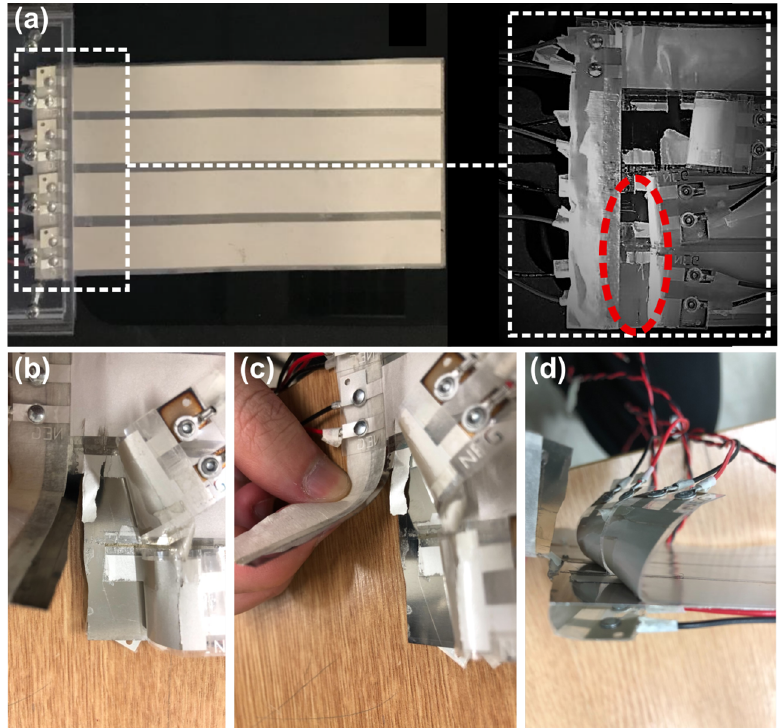
Figure 6. ( a ) Inverted flag before the endurance test and detail of the failed flag after testing: the inset shows the flag where the clamp has been removed and the PVDF strips have been lifted to inspect the metal core and reveal the vertical crack responsible for the flag failure (red ellipse); ( b – d ) close-up views of the crack.